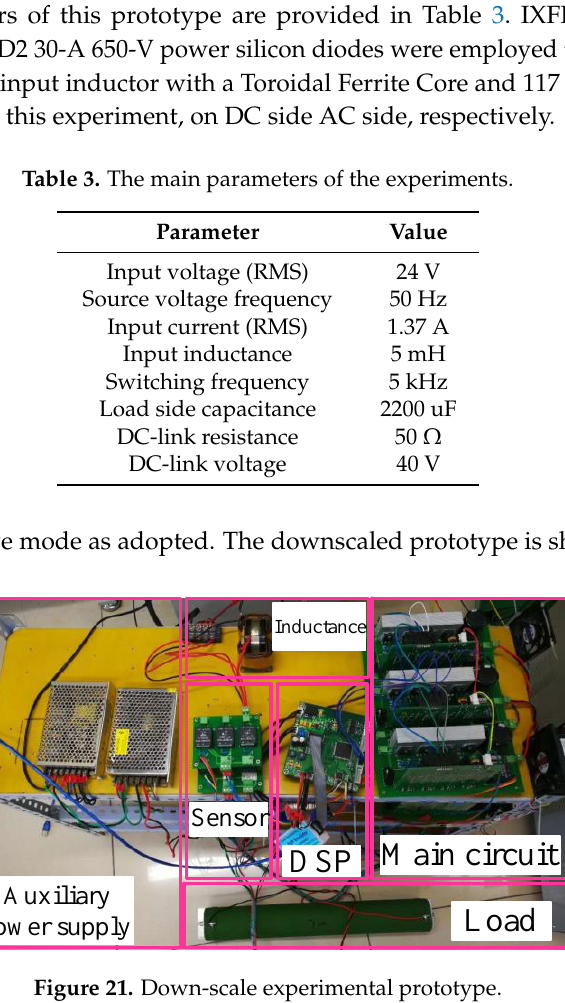
Figure 21. Down-scale experimental prototype.